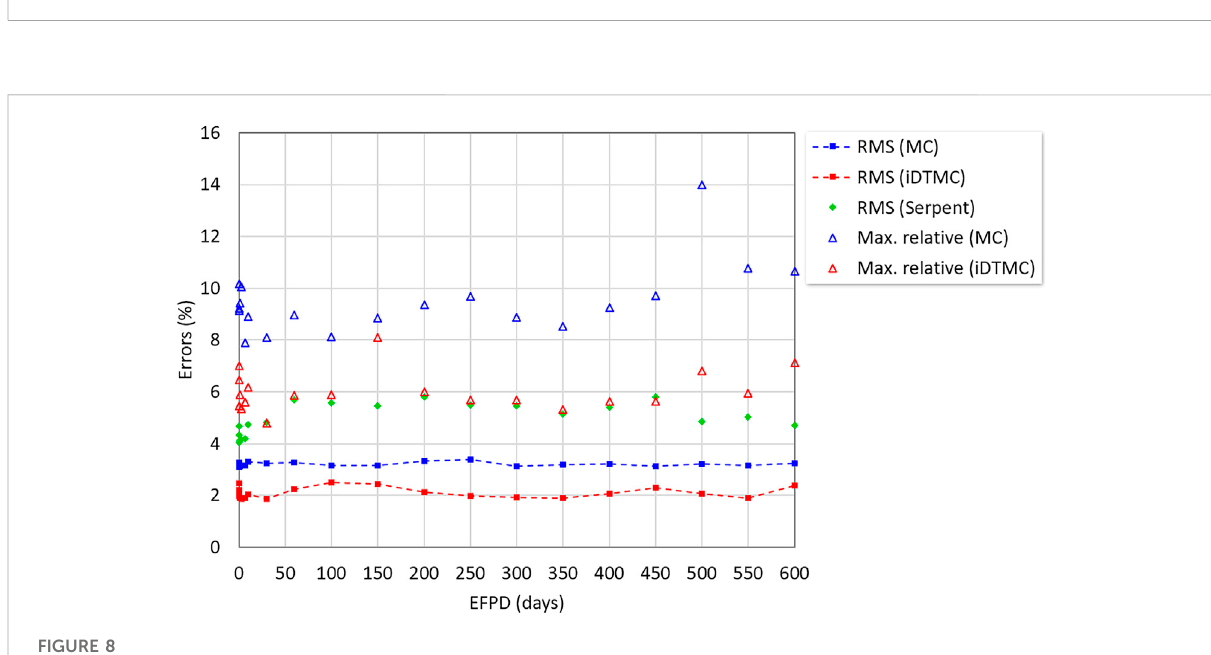
FIGURE 8 Errors for pin power distribution (active cycle